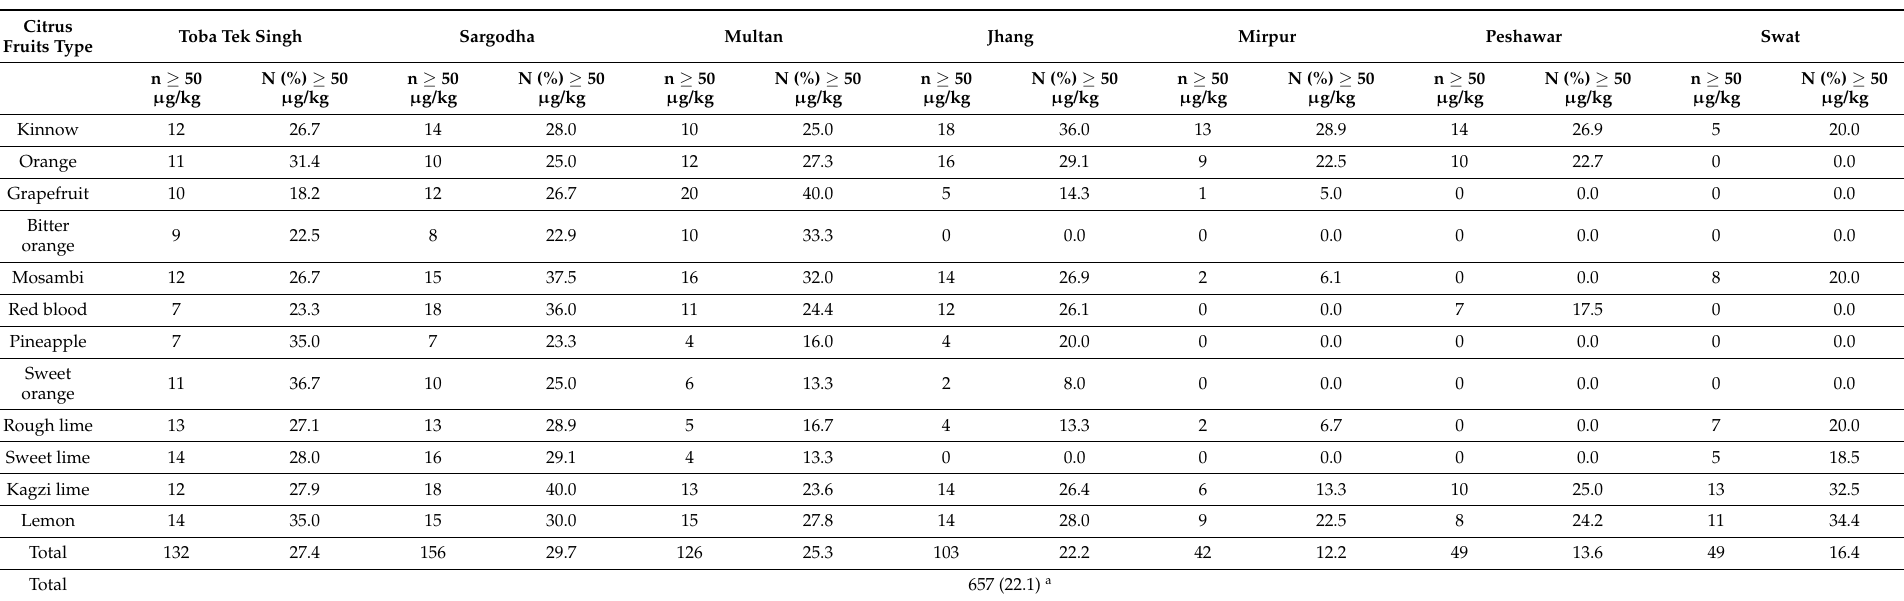
Table 4. The percentage of samples of Patulin exceeds the recommended limits of the European